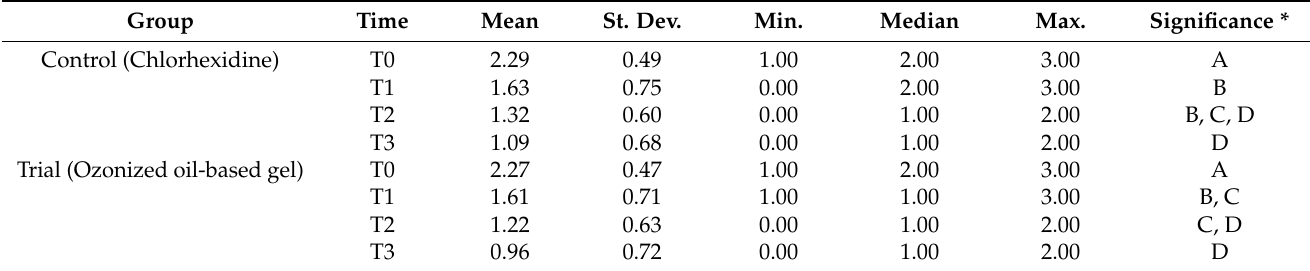
Table 9. Descriptive statistics of Marginal Mucosal Conditions